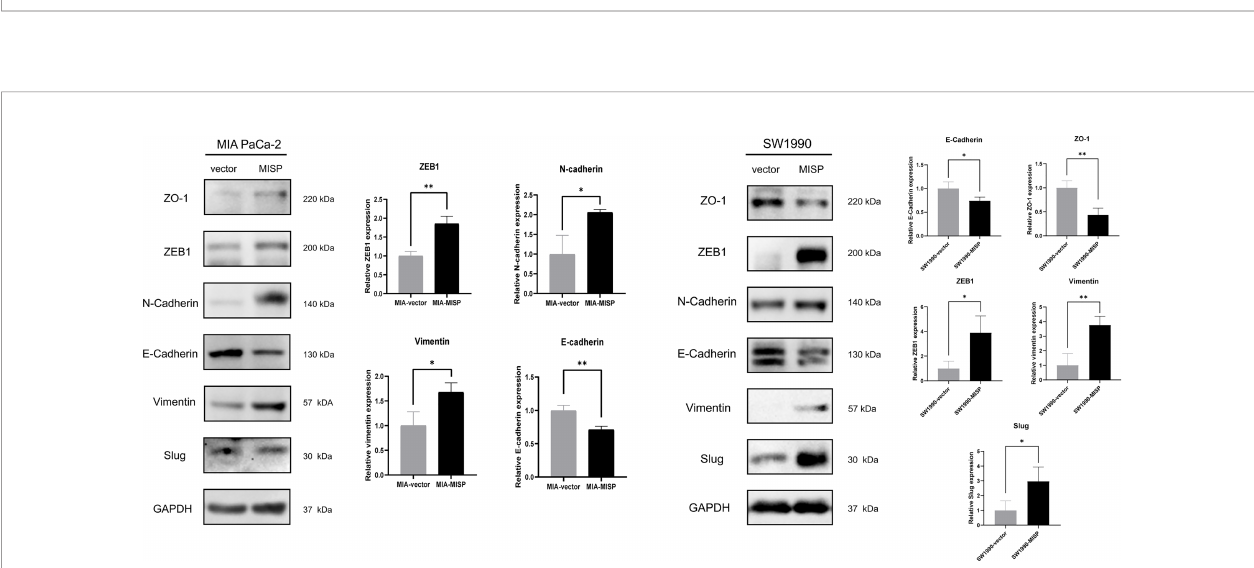
FIGURE 6 | MISP induces EMT in PDAC cells. The protein expression of EMT markers (ZO-1, N-cadherin, E-cadherin, and vimentin) and EMT-TFs (Slug, ZEB1) were measured by western blotting. GAPDH was used as the loading control. MIA: MIA PaCa-2 cells. *P<0.05, **P<0.01.